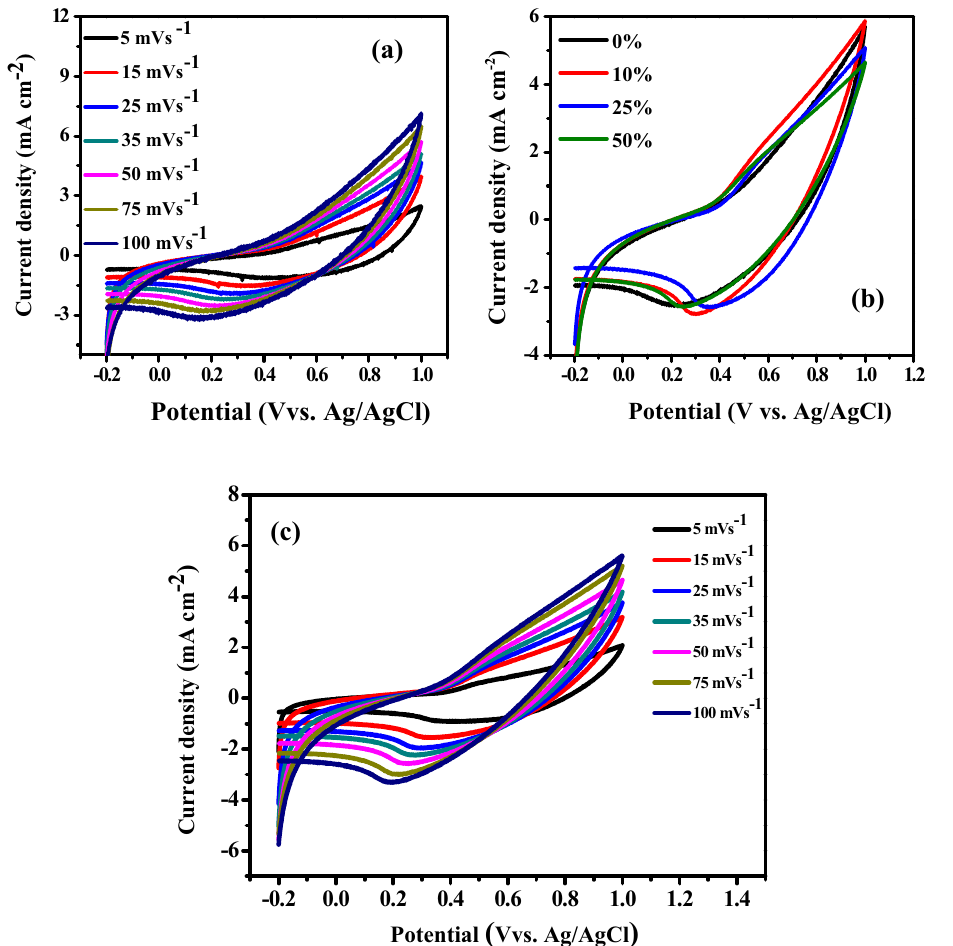
Figure 5. ( a ) CV curves of P3HT at different scan rates, ( b ) CV curves of P3HT/SWCNTs electrodes with different SWCNTs ratios at 50 mV s −1 and ( c ) CV curves of P3HT/50% SWCNTs at different scan rates